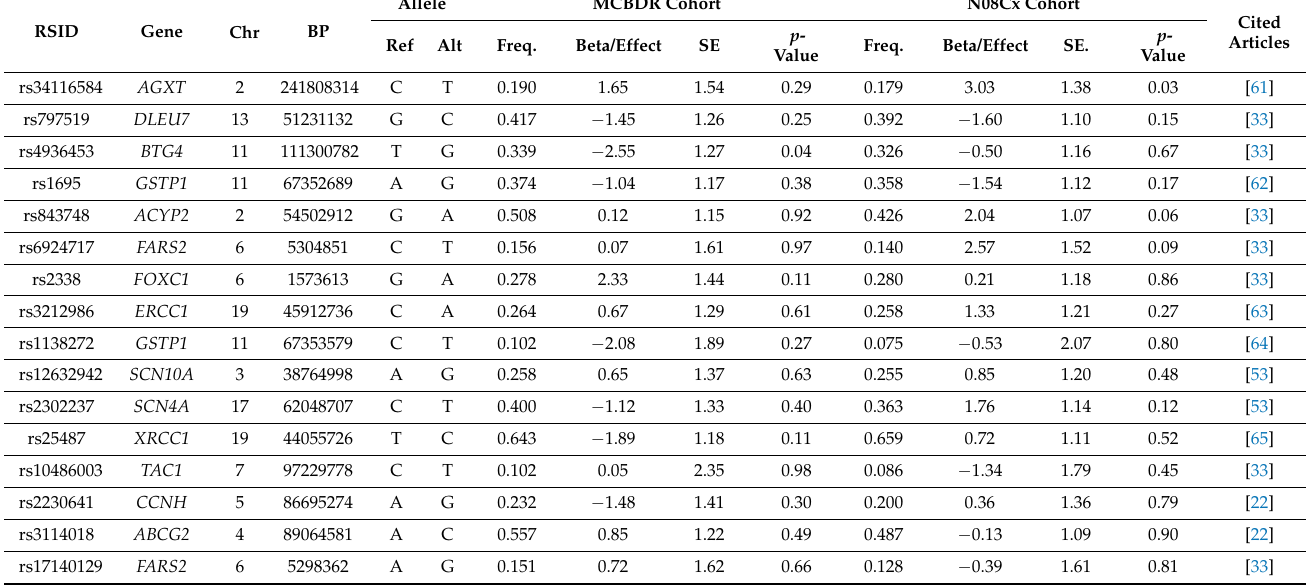
Table 8. Candidate SNPs associated with CIPN from oxaliplatin-based treatment in previous studies.